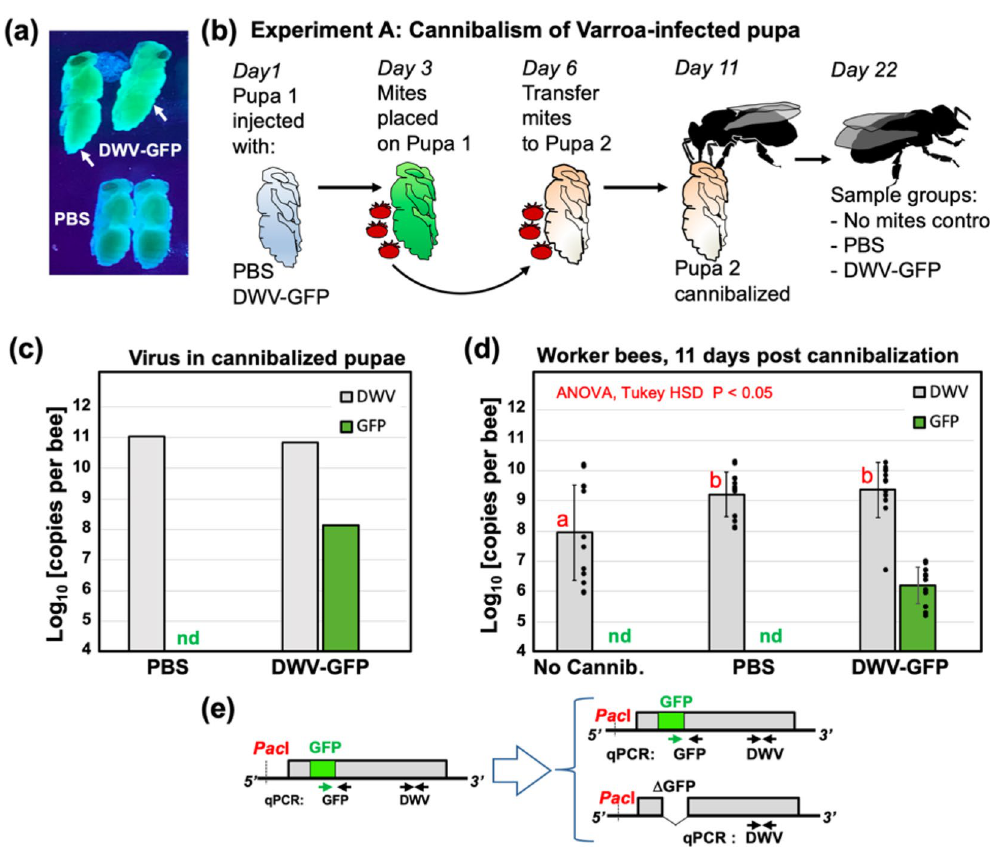
Figure 2. DWV infection in worker bees following cannibalization of pupae infected by Varroa mites (Experiment A). ( a ) Honey bee pupae, control and DWV-GFP-infected (pointed with arrows) which were used to rear Varroa mites (Pupae 1), illuminated with 395 nm UV light; ( b ) Schematic representation of the experiment. ( c ) DWV and GFP RNA loads in Varroa exposed Pupae 2 offered for cannibalization. ( d ) Average DWV and GFP RNA loads in individual worker bees, error bars indicate standard deviation. For DWV, red letters above bars indicate significantly and non-significantly different groups (ANOVA). DWV and GFP copy number in individual pupae are indicated by black dots, nd not detectable levels. ( e ) Schematic representation of the DWV-GFP RNA genome and genetic changes following deletion of the GFP-coding sequence, positions of qPCR primers used for quantification of DWV and GFP RNA and genetic changes in DWV-GFP following deletion of the GFP-coding sequence are